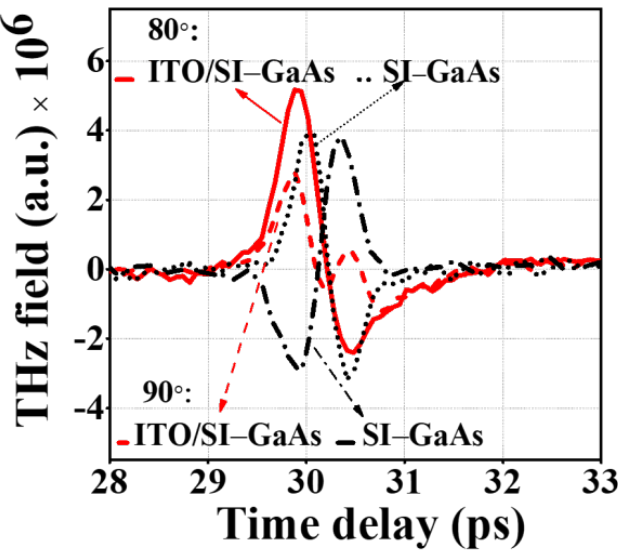
Figure 9. THz waveforms emitted by the bare GaAs substrate and ITO/GaAs sample at polarization angles of 80 ◦ (solid line for ITO/SI − GaAs and short dots for SI − GaAs) and 90 ◦ (short dash for ITO/SI − GaAs and short dash dots for SI − GaAs).